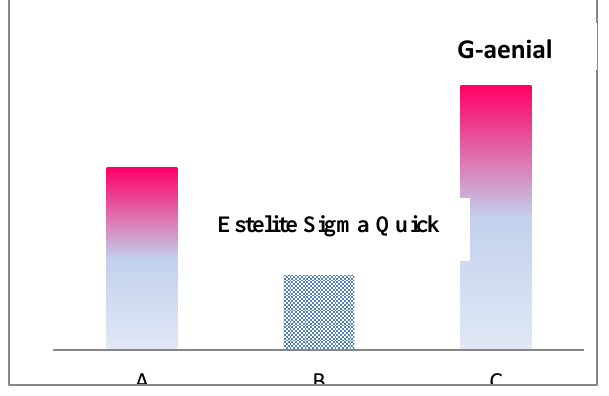
Figure 4: showing mean of radiopacity values in mm for all